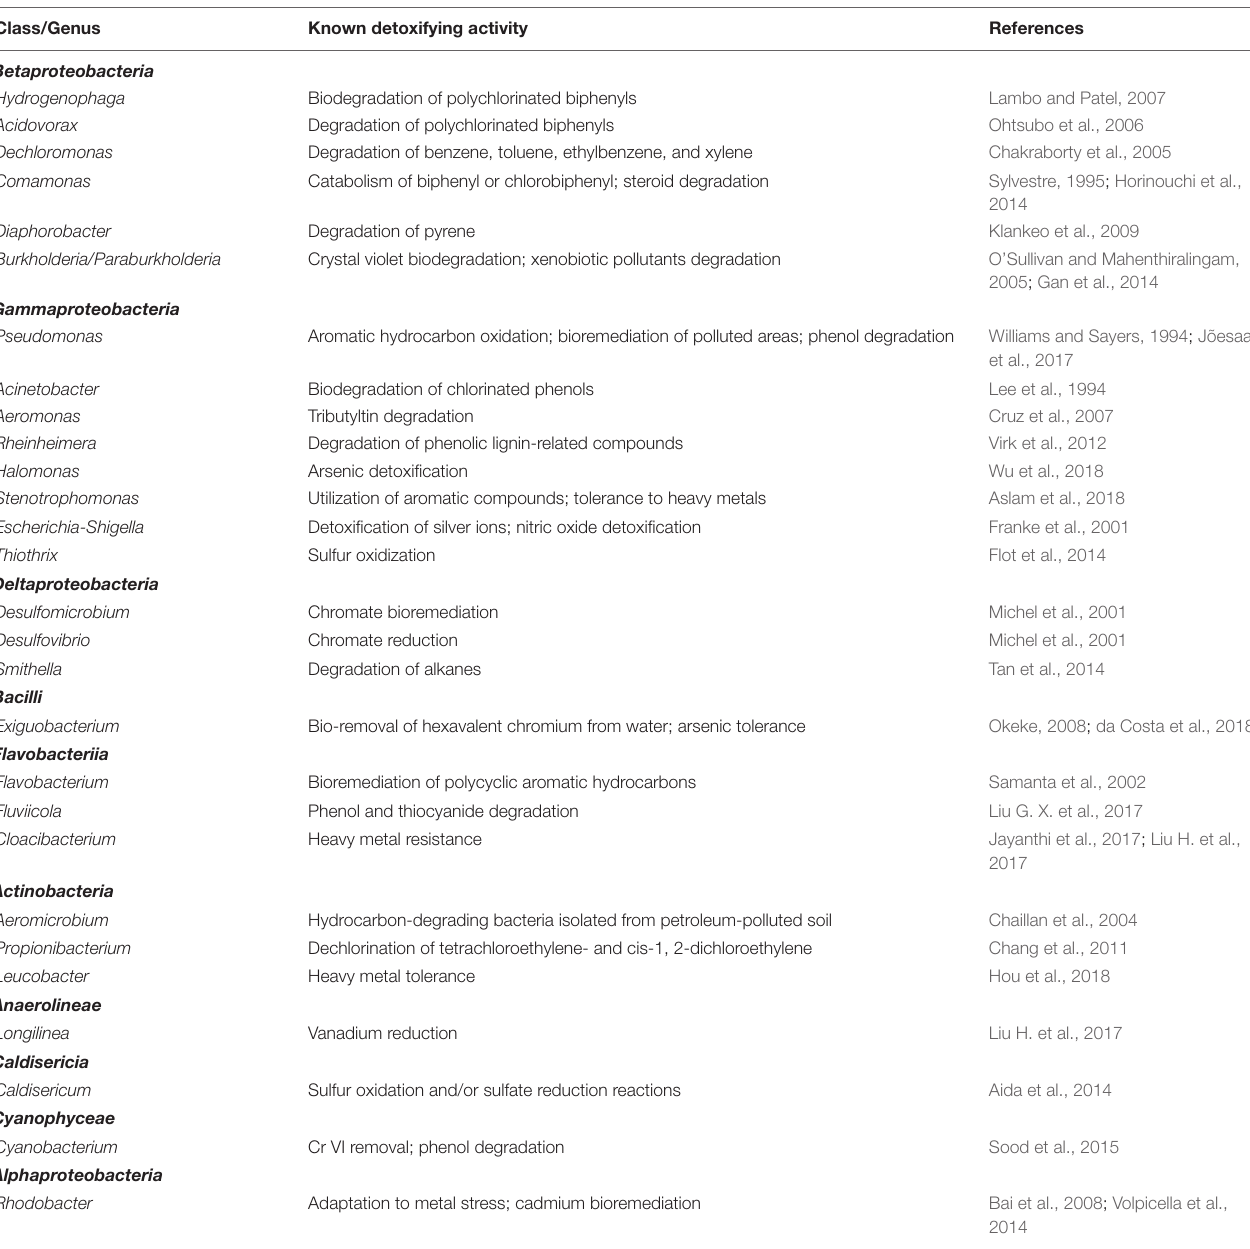
TABLE 1 | A list of bacterial genera that were identified in C. transvaalensis egg masses, larvae or pupa and that have the potential to detoxify toxic